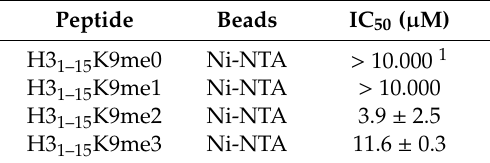
Table 4. Disruption of the H3 1-15 K9me3-biotin:ATRX ADD -His PPI by H3 peptides. Peptide